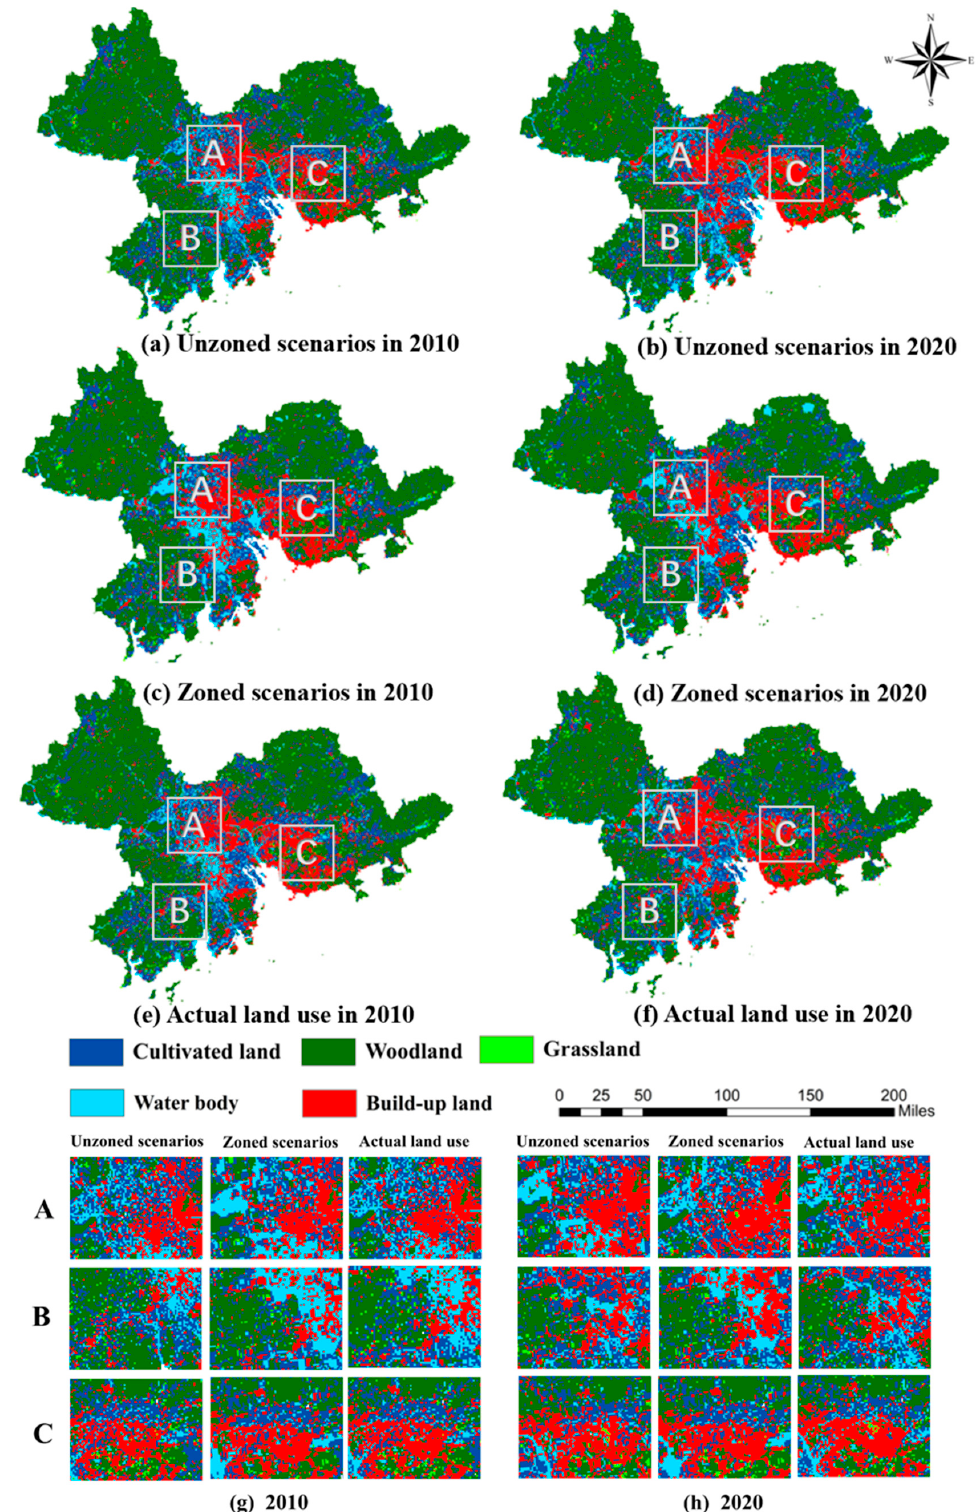
Figure 5. Comparison of simulation results of land-use change in 2010 and 2020: ( a ) Simulation of unzoned scenarios in 2010; ( b ) Simulation of unzoned scenarios in 2020; ( c ) Simulation under zoned scenario in 2010; ( d ) Simulation under zoned scenario in 2020; ( e ) Actual data in the Pearl River Delta in 2010; and ( f ) Actual data in the Pearl River Delta in 2020. ( g ) Comparison of local area results in 2010; ( h ) Comparison of local area results in